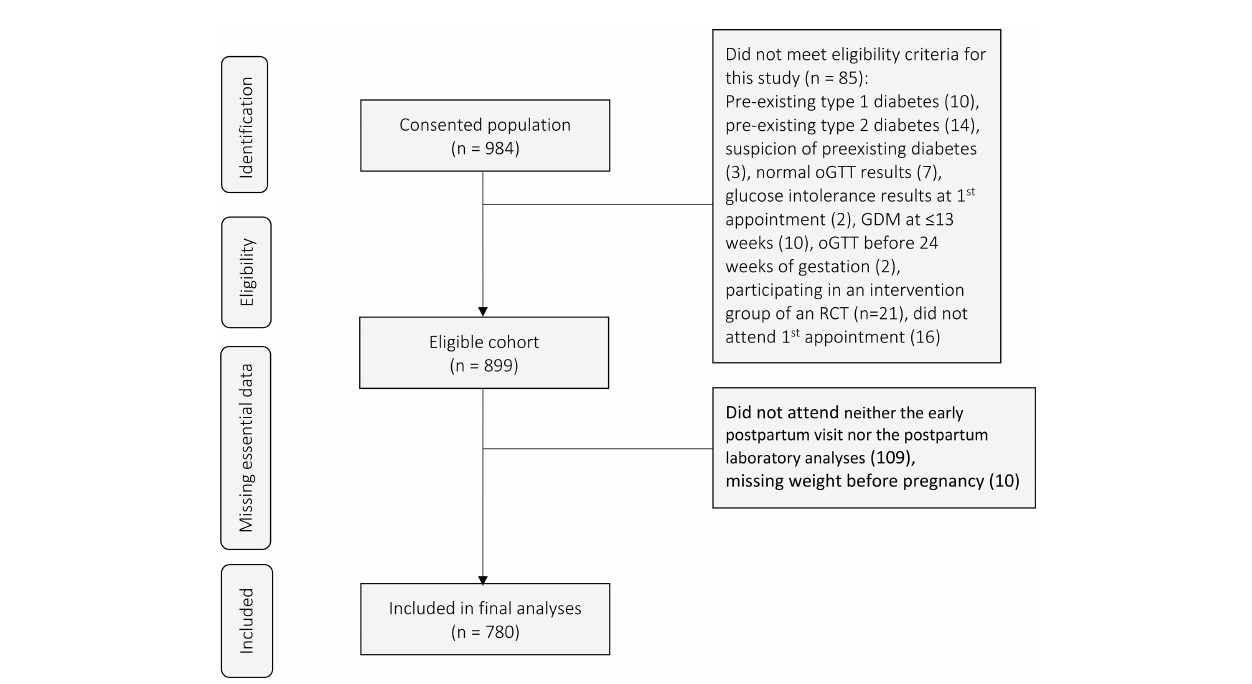
FIGURE 1 | Flow chart of participating patients. oGTT, oral Glucose Tolerance Test; GDM, gestational diabetes mellitus; RCT, randomized controlled